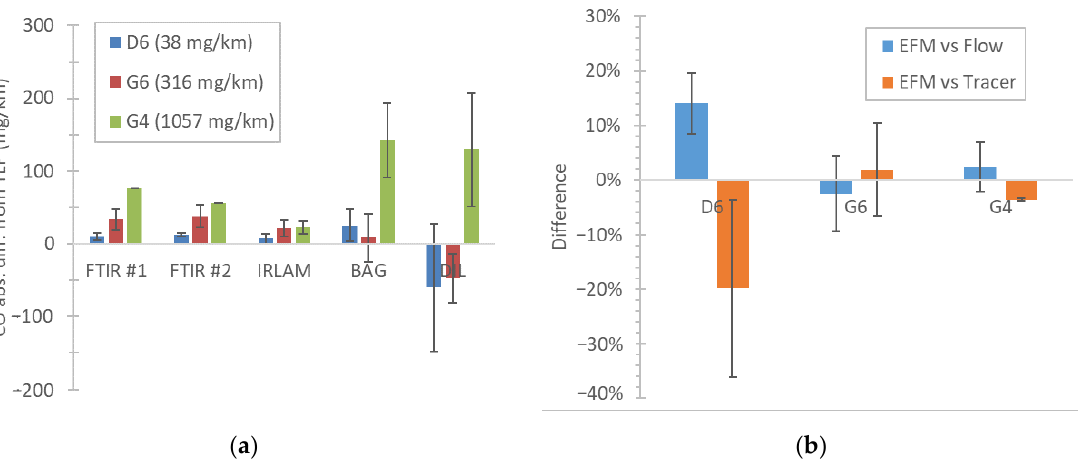
Figure 11. Absolute differences of the instruments from their mean: ( a ) CO; ( b ) exhaust flow. Table 4. Measured absolute uncertainty with the reference (BAG, DIL) and new techniques (IRLAM, FTIR), in comparison with the proposed Euro 7 limits. The values were based on the comparisons with the